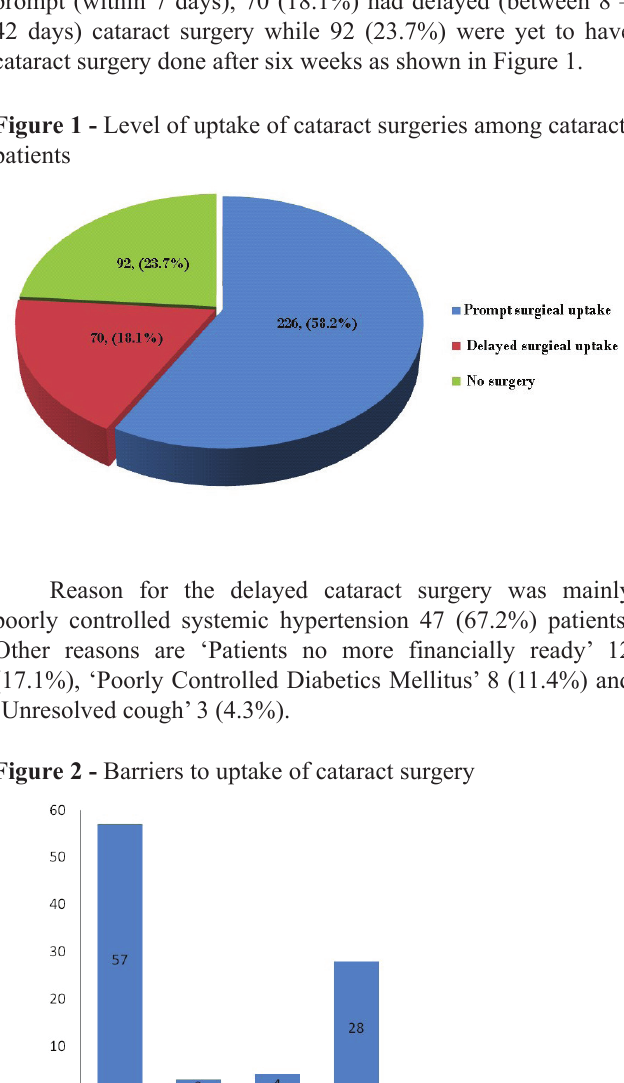
At the end of the study period, 92 (23.7%) cataract patients never had cataract surgery done. Reasons for not having cataract surgery done were shown in Figure 2. Poorly controlled systemic hypertension in 57 (62.0%) patients was the most common barrier to uptake of cataract